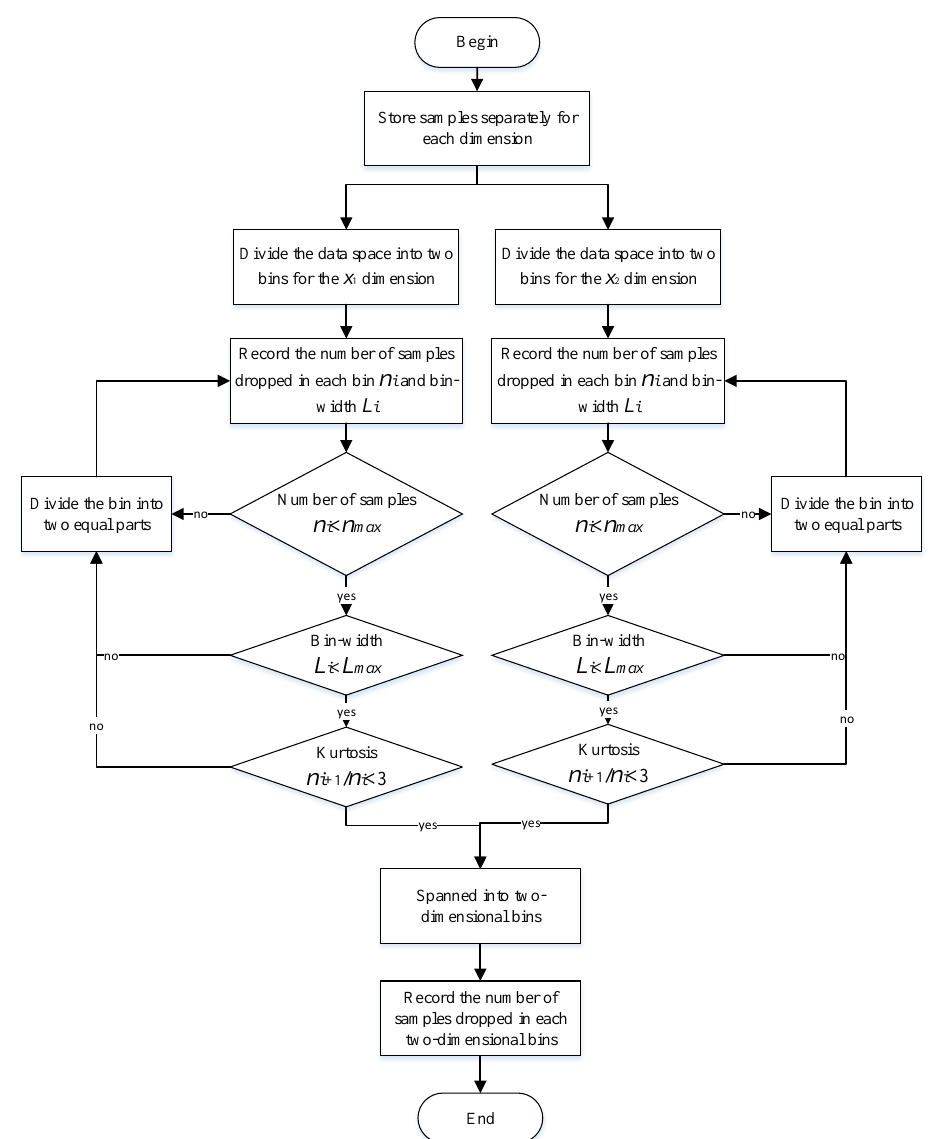
Figure 2. Bivariate adaptive binned method based on quadtree algorithm.